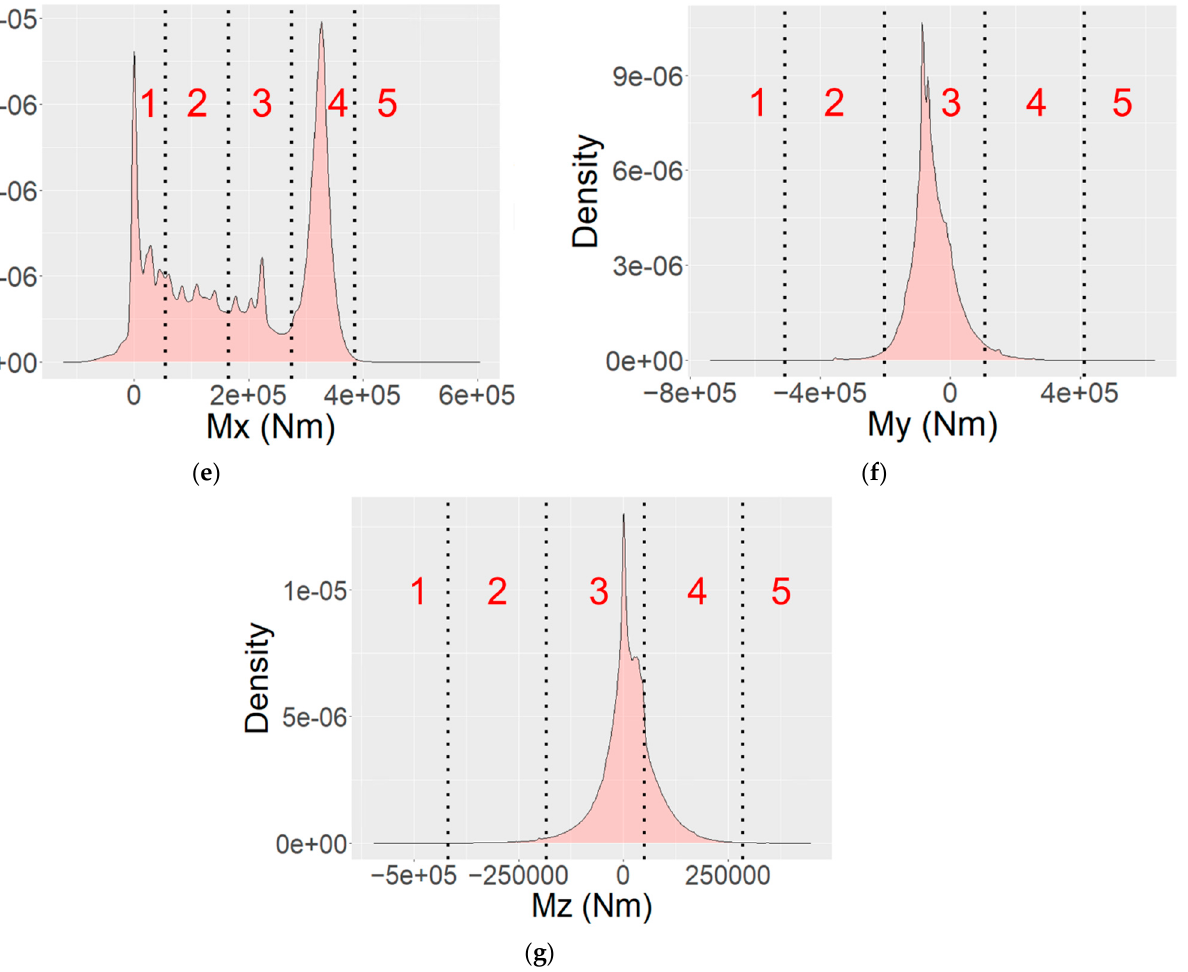
Figure 6. Simulated distributions and factor levels for each of the respective factors listed in Table 6: ( a )-( g ) covering factors n, Fx, Fy, Fz, Mx, My, and Mz, respectively, with the respective level num- ber indicated with the red numerals and the respective level boundaries illustrated by the dotted vertical lines.